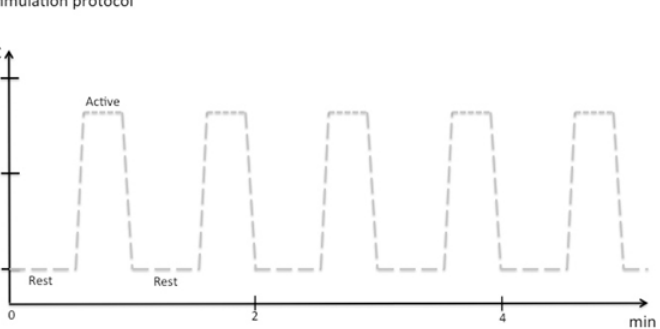
Fig 3. Stimulation paradigm: During functional imaging, blocks of noxious heat stimulation (pain) were delivered from baseline blocks (no pain) at 35°C. For noxious heat we chose the pre-determined individual temperature that corresponded to 5 on the numeric rating scale (NRS). One scan session thus consisted of 6 baseline blocks (30 s/block) that was interleaved by 5 noxious heat blocks (25 s/blocks), not including the ramp periods. The rate of temperature change was 4°C/s. The ramps were modeled in defining the explanatory variables (EVs) for fMRI data